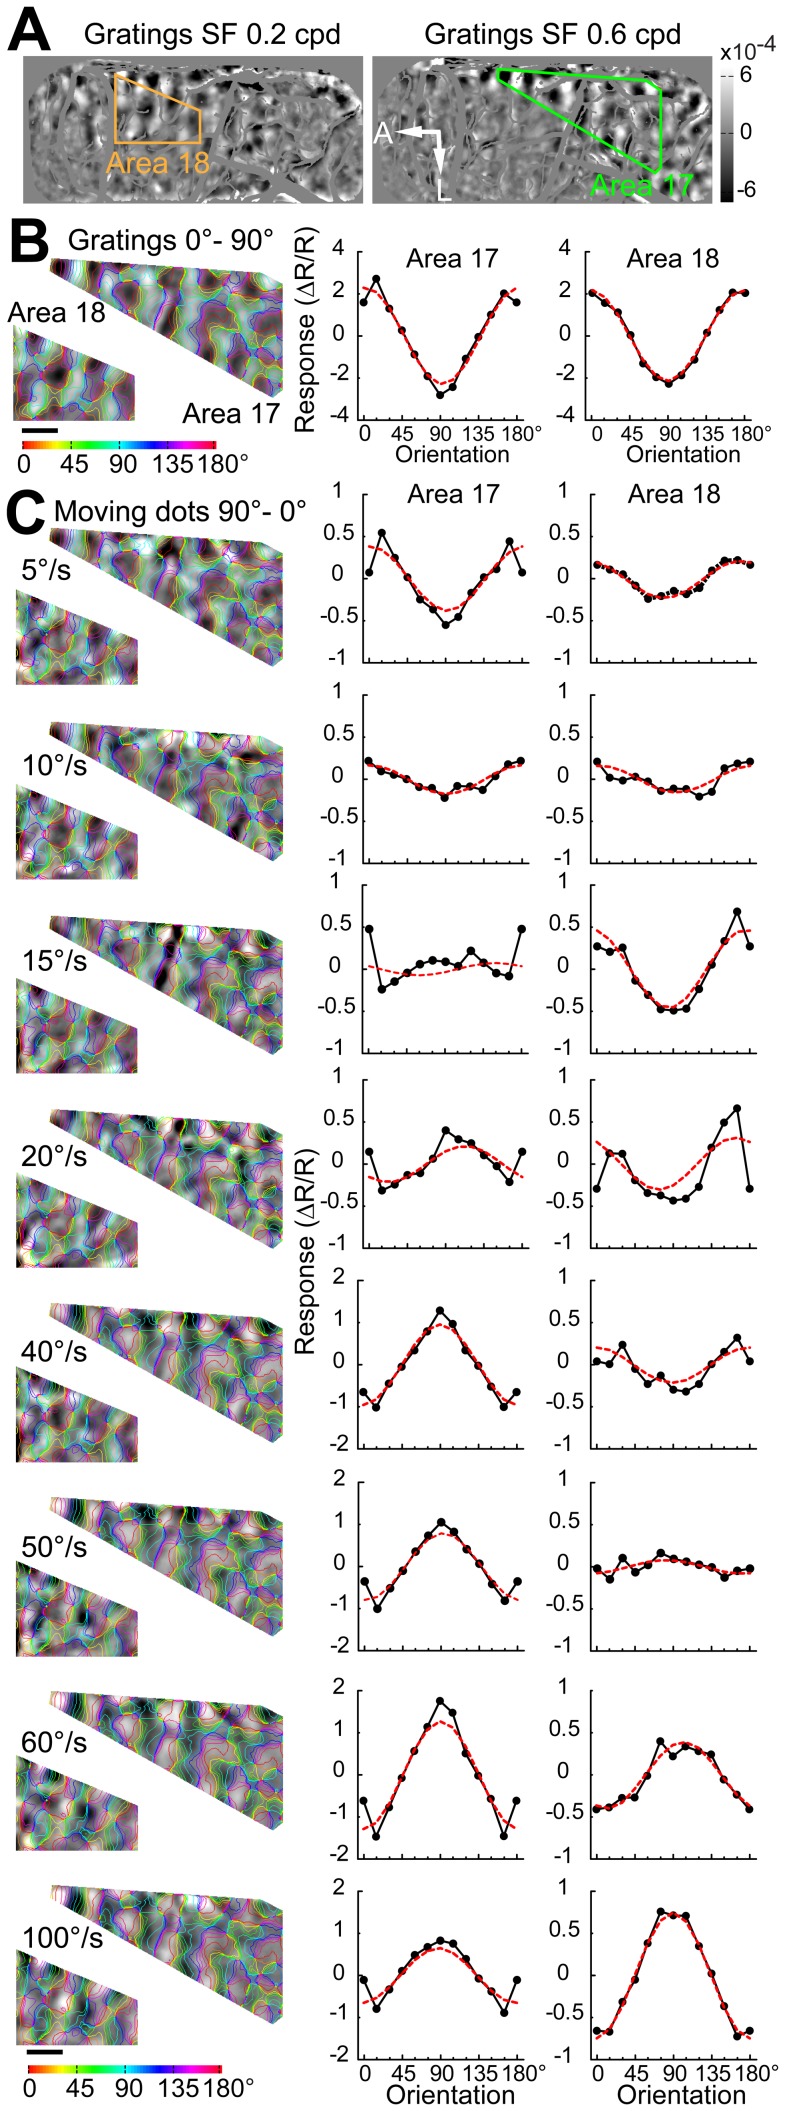
Differential population responses to different motion axes.(A) Differential orientation maps generated by drifting sine-wave gratings with SFs of 0.6 cpd and 0.2 cpd for driving areas 17 and 18, respectively. Blood vessels and marginal regions were masked gray on the maps. Responses of selected regions from areas 17 and 18 (green and orange outlines) were analyzed in (B) and (C). A, Anterior; L, lateral. (B) Differential orientation maps (0°–90°) and the corresponding results of response profile analysis acquired using sine-wave grating stimuli. (C) Differential motion-axis maps (90°–0°) and the corresponding results of response profile analysis obtained by moving random-dot stimuli with different speeds. Colored iso-orientation contours were derived from the orientation preference map for sine-wave grating stimuli and were superimposed on the gray images. The red curves in the plots represent the best fitting cosine functions. The values of the ordinates correspond to the recorded responses () × 104. Note that the scales of y axes are different between low and high speeds. Scale bar: 1 mm.